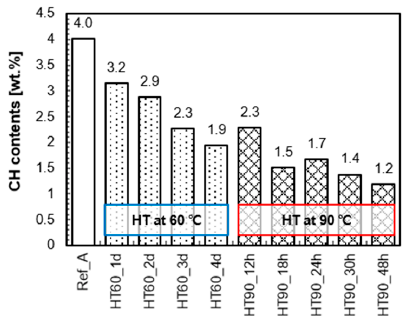
Figure 6. Portlandite contents in UHPC at 7 days measured by TGA.